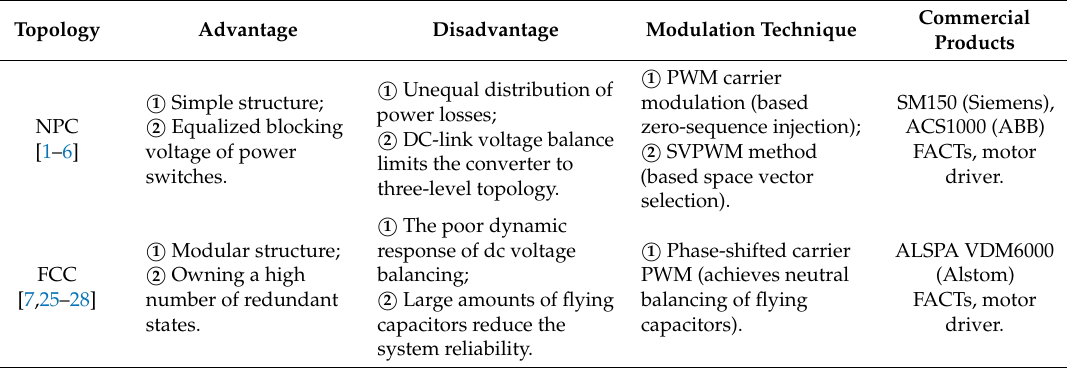
Table 5. Performance summary of multilevel